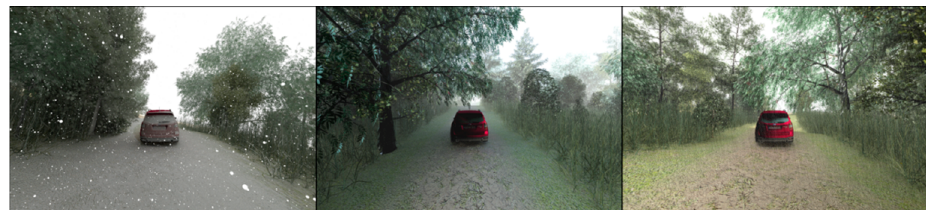
Figure 2. Simulation of snow ( left ), fog ( middle ), and rain ( right ) in MAVS. The terrain was created automatically with